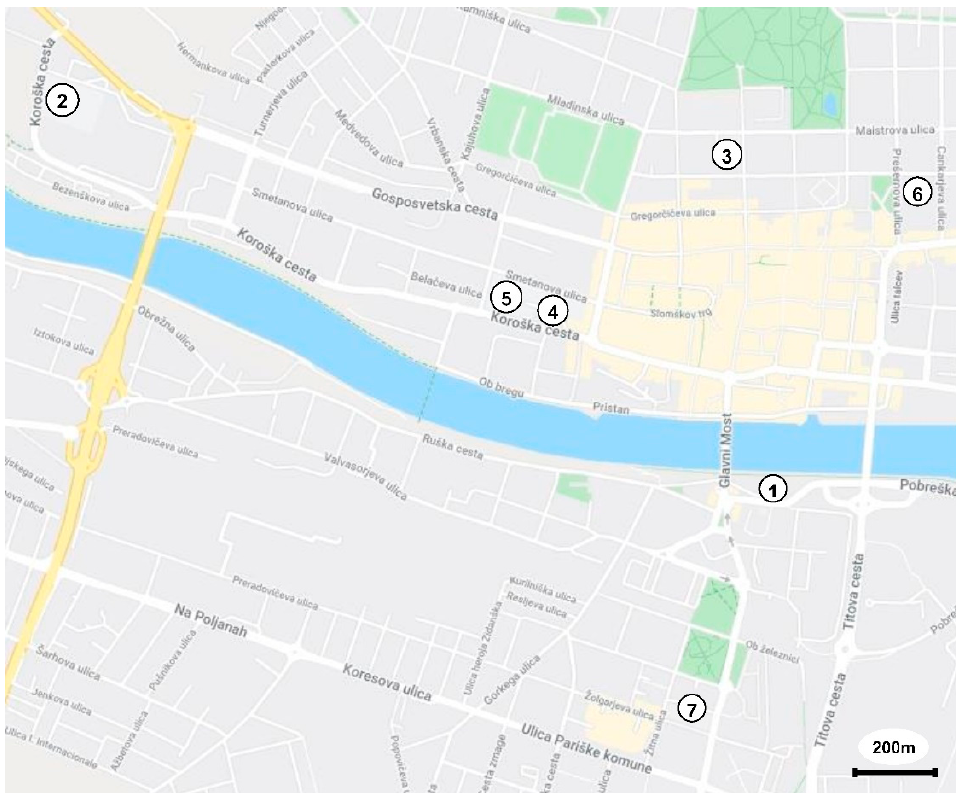
Figure 2. Research area, including locations of faculties in city center of Maribor. Note: 11 faculties are located on 7 different locations (legend: 1—Faculty of Medicine (MF); 2—Faculty of Natural